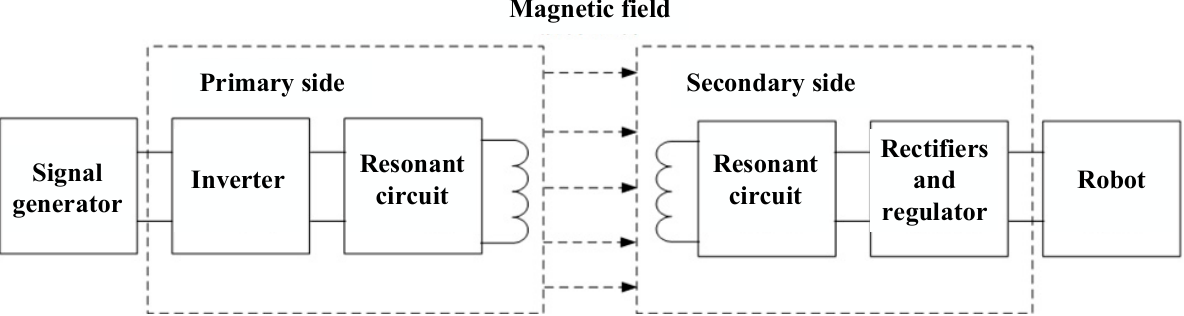
Figure 2. Block diagram of wireless power transmission.